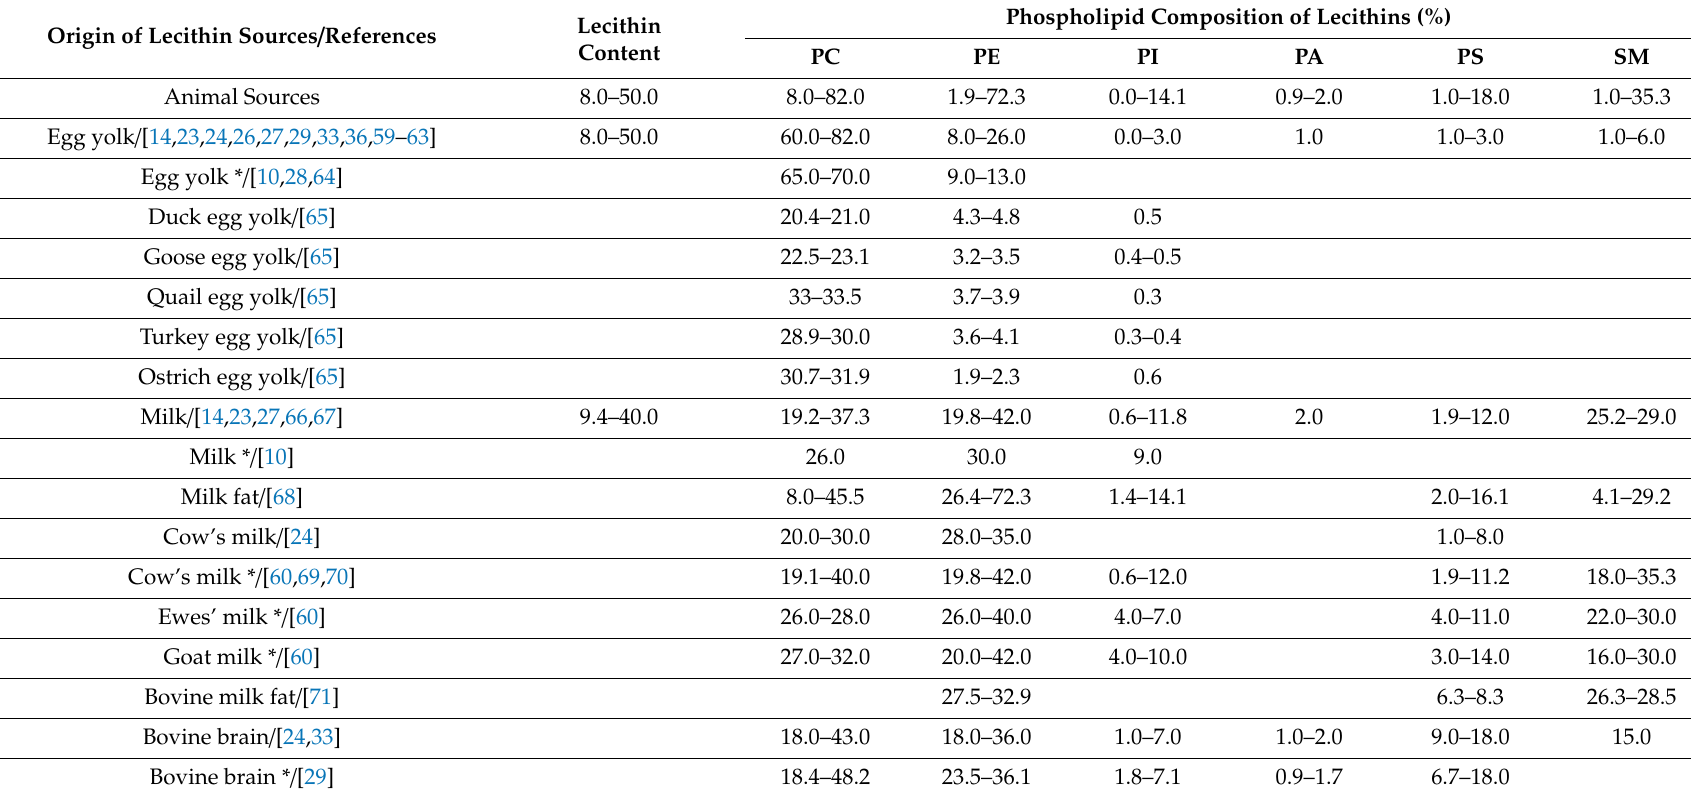
Table 2. Phospholipid composition of natural lecithins from animal